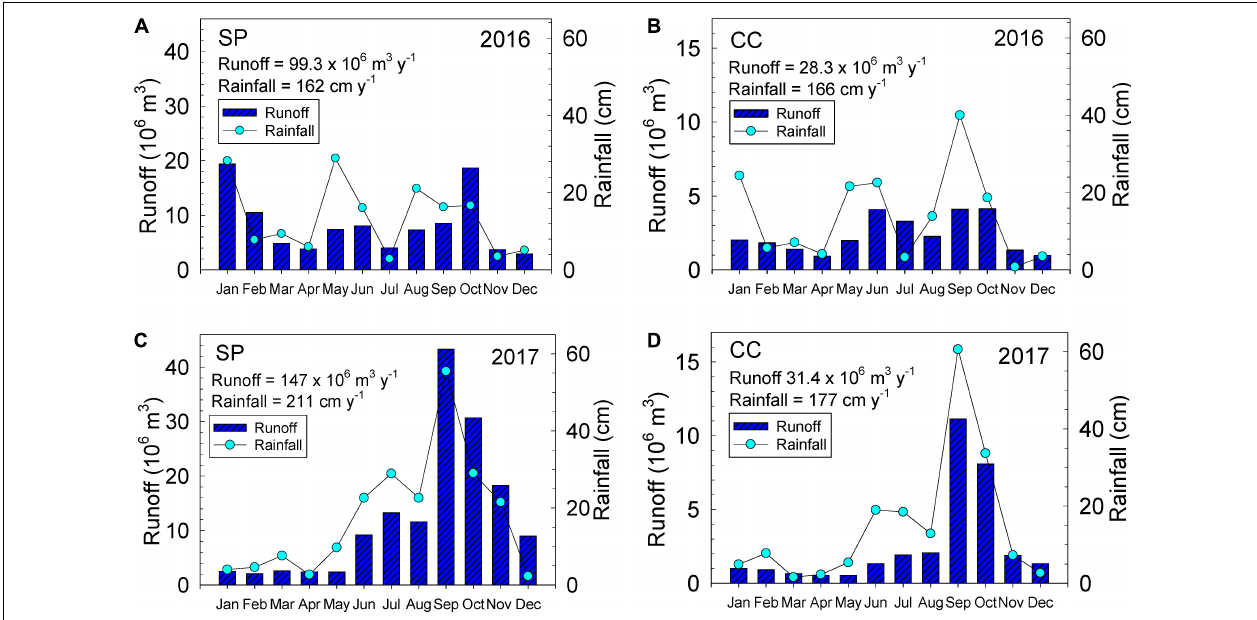
FIGURE 2 | Monthly rainfall and runoff during 2016 and 2017 for (A,C) South Prong Saint Sebastian River (SP) and (B,D) Crane Creek (CC). Totals for each year shown on upper left of graphs. Rainfall data from National Oceanic and Atmospheric Administration [NOAA] (2020) and runoff from United States Geological Survey [USGS]